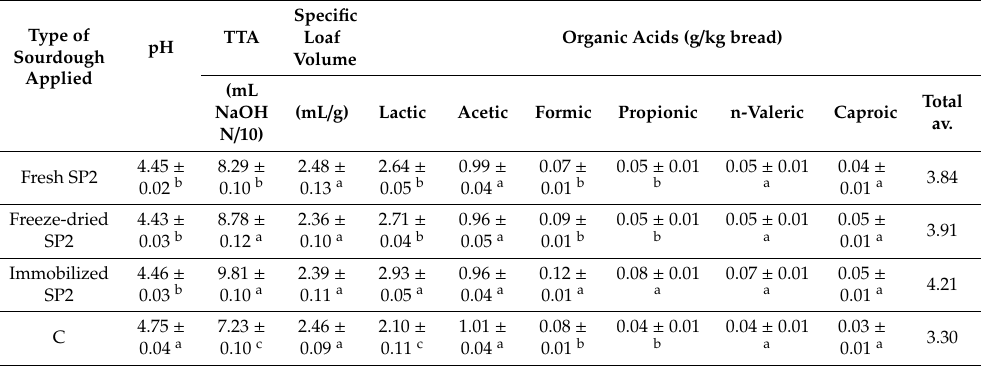
Table 1. Physicochemical characteristics of breads made with sourdough containing P. pentosaceus SP2 cells (Fresh SP2), freeze-dried P. pentosaceus SP2 cells (Freeze-dried SP2), immobilized freeze-dried P. pentosaceus SP2 cells (Immobilized SP2), as well as with the commercial sourdough